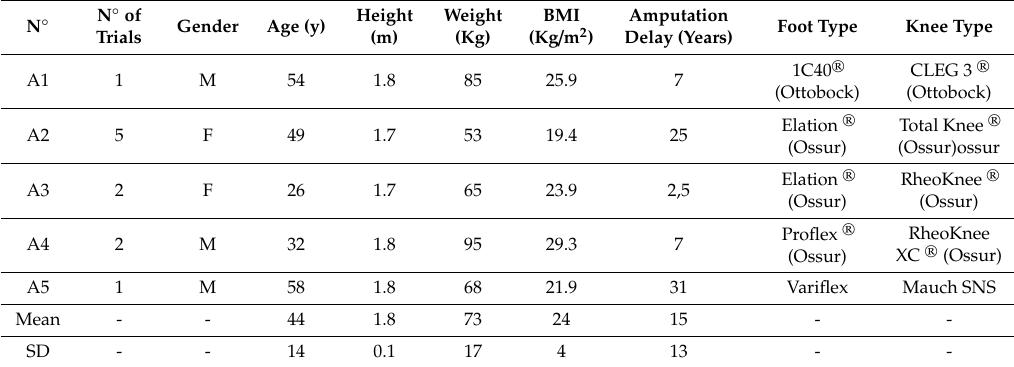
Table 1. Characteristics of participants with transfemoral amputation (BMI: Body Mass Index).